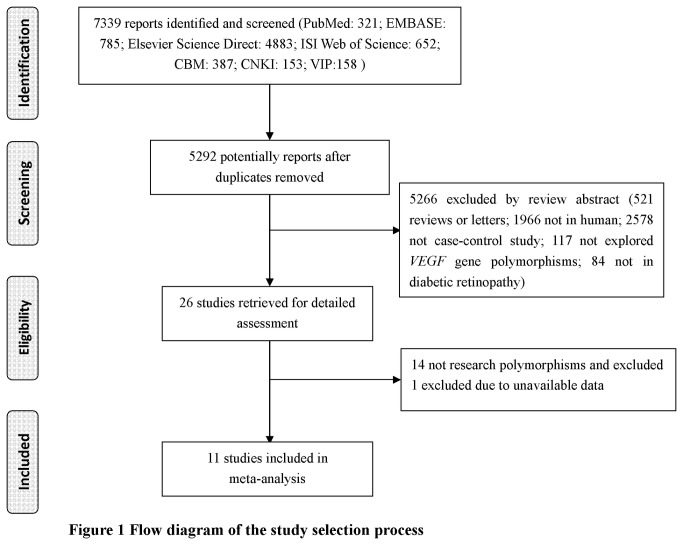
Flow diagram of the study selection process.